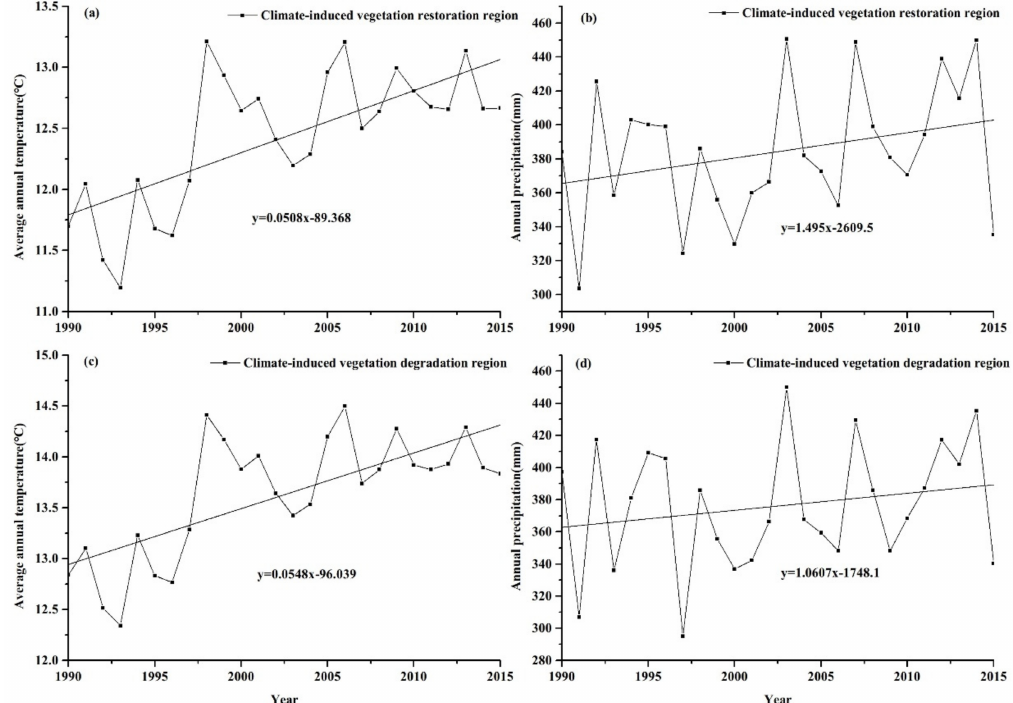
Figure 12. Annual average temperature and annual precipitation trends in climate-induced vegetation restoration ( a , b ) and degradation from 1990 to 2015 ( c , d